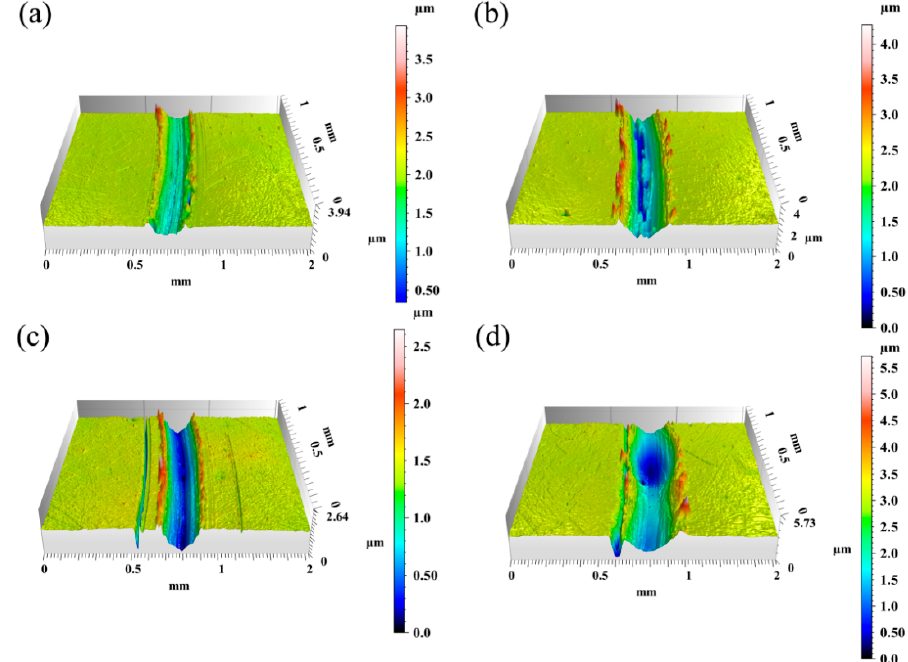
Figure 6. Typical 3D profile images of the wear tracks after sliding 1.0 × 10 5 cycles in vacuum for ( a )